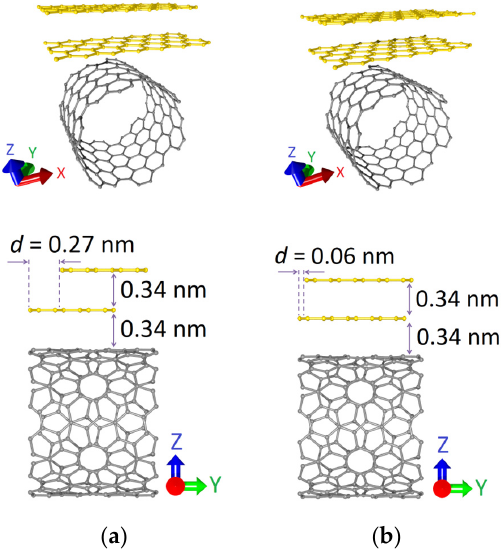
Figure 1. Atomic structure of the initial (before optimization) configurations of the supercells of bi-layer graphene-SWCNT (12,6) hybrid films with island topology: ( a ) model V1; ( b ) model V2. The supercells of bilayer graphene-SWCNT (12,6) hybrid films with an island topology after optimization of the atomic structure ( fi nding of the equilibrium con fi guration) are shown in Figure 2. Comparing Figures 1 and 2, it can be noted that both the nanotube (12,6) and the bilayer graphene as part of the supercells of models V1 and V2 are deformed during the optimization of the atomic structure of the supercell. Translation vectors of supercells of the considered topological models: L x = 1.707 nm and L y = 1.110 nm for model V1, L x = 1.723 nm, and L y = 1.134 nm for model V2. Previously, based on the results of calculating the binding energy, it was found that the supercells of the considered topolog- ical models are energetically stable [50].